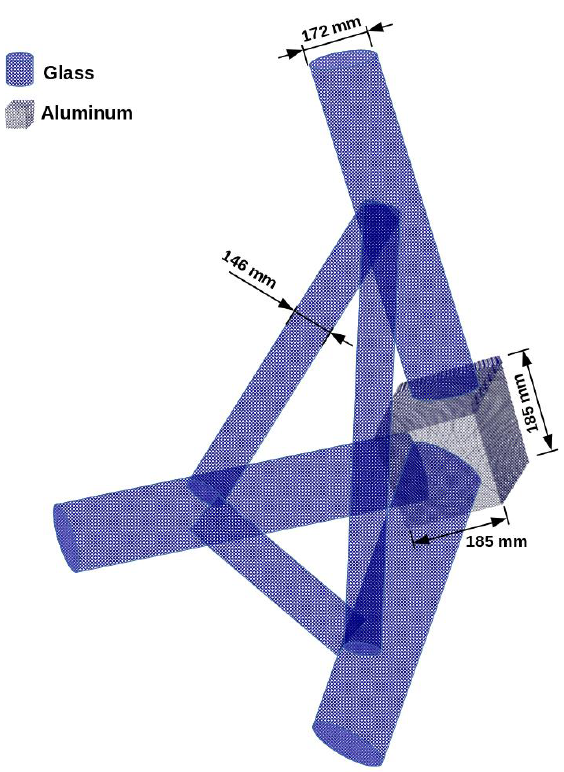
Figure 4. Triangular structure design ensures additional stiffness at the corners of the